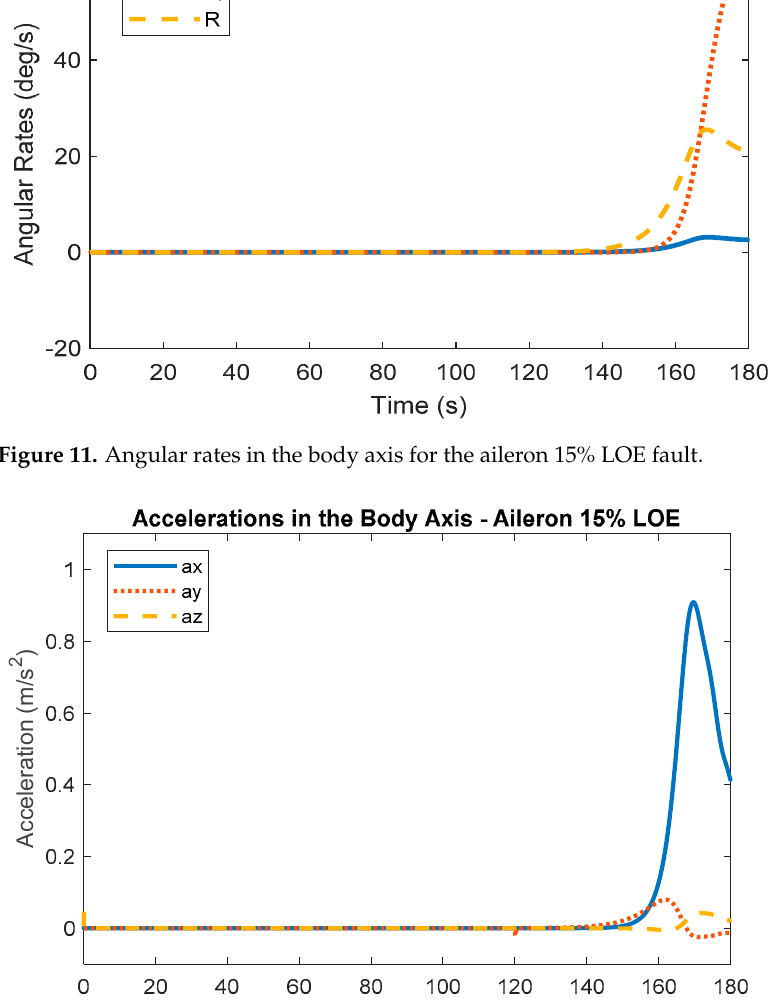
Figure 13. Change in dynamics for the aileron 15% LOE fault. The SVM models are trained for each of the three percentages of LOE and evaluated, with the results shown in Table 4. The aileron SVM model for each percentage performed is worse than the corresponding elevator SVM model. On average, 5% of data are misclas- sified across each of the three models. Each model also records a relatively high cross-